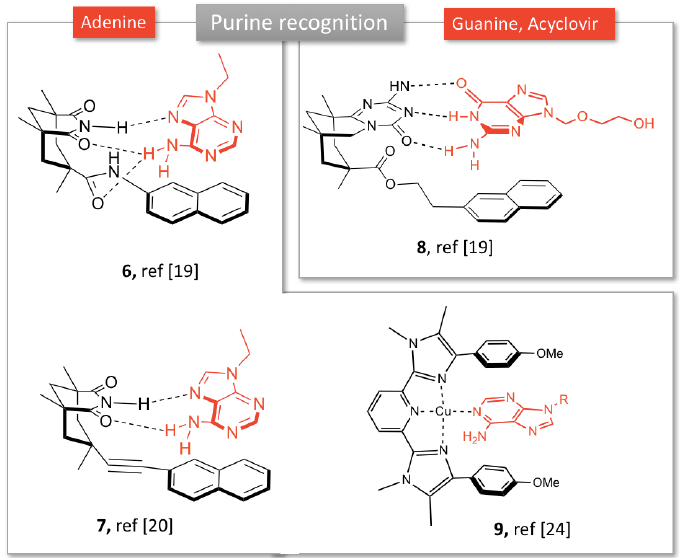
Figure 2. Examples of synthetic receptors for adenine and guanosine recognition.